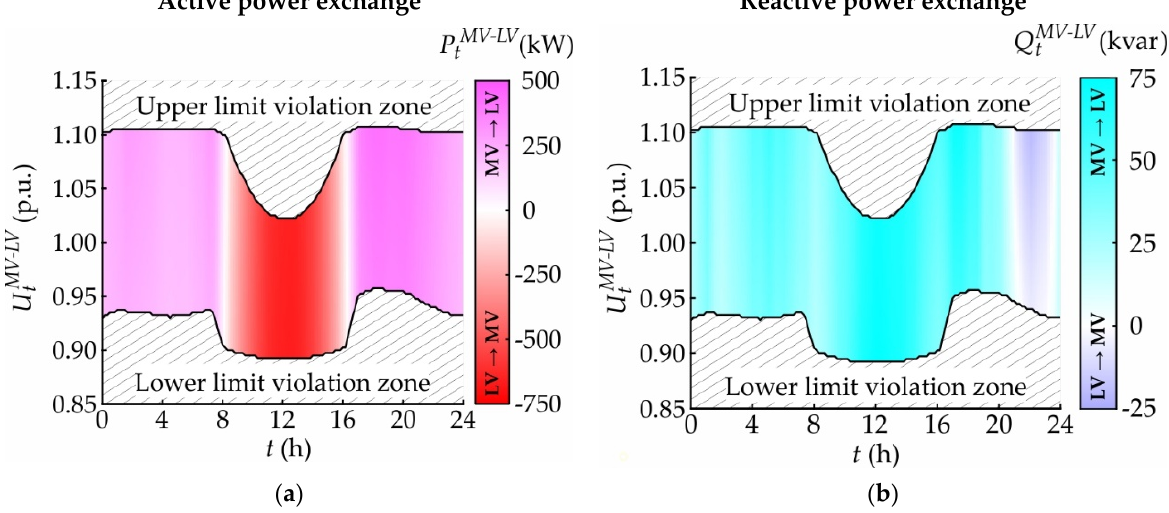
Figure A4. Daily behavior of the urban LV grid for various voltages at the MV–LV boundary node: (a) MV–LV active power exchange; (b) MV–LV reactive power exchange.